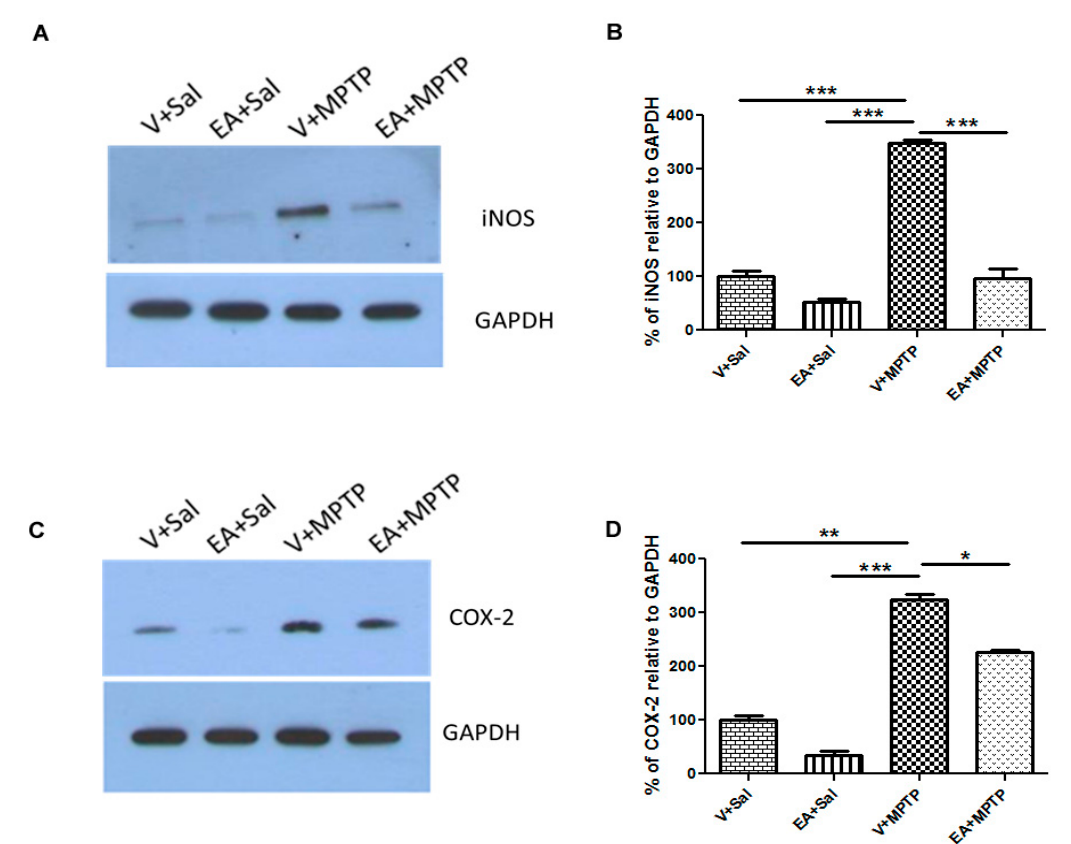
Figure 5. Expression of striatal inducible nitric oxide synthase (iNOS) and cyclooxygenase-2 (COX-2), as measured by Western blot analysis ( A , C ). A significant increase in iNOS was observed in the MPTP group relative to the control (Vehicle + Saline) group. Ellagic acid (EA) treatment prior to MPTP injection significantly decreased the expression of iNOS relative to the MPTP group ( A , B ). Similarly, COX-2 expression was increased significantly in MPTP group relative to the control (Vehicle + Saline) group. EA treatment decreased the COX-2 expression relative to the MPTP group ( C , D ). Values are expressed as percentage of mean ± SEM relative to control group (Vehicle + Saline). Significance is denoted as * p < 0.05, ** p < 0.01 and *** p < 0.001.